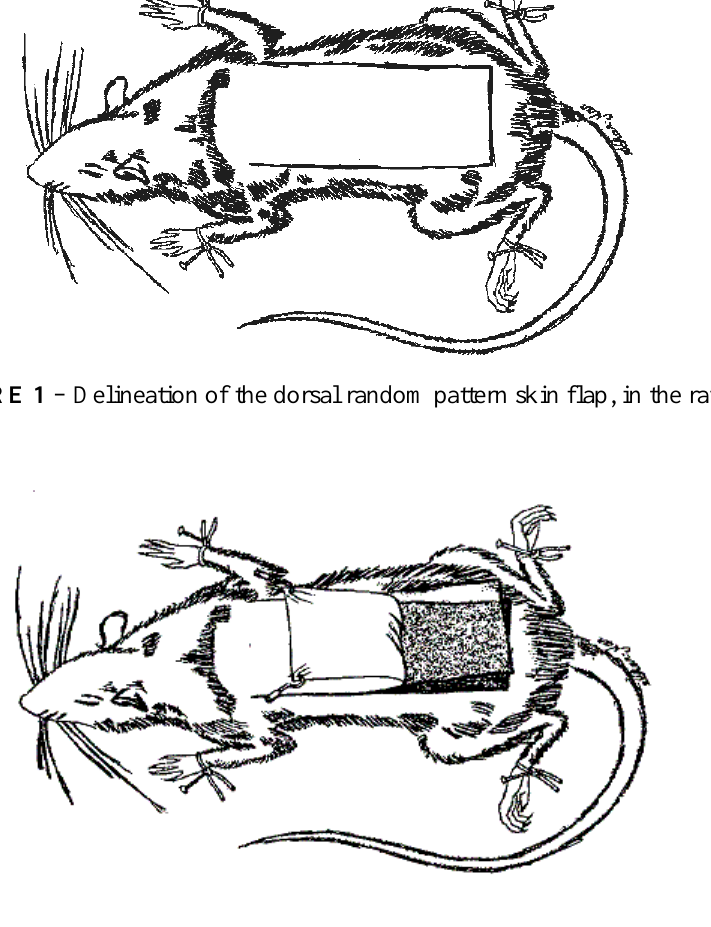
FIGURE 2 – Interposition of a plastic barrier between the flap and its donor